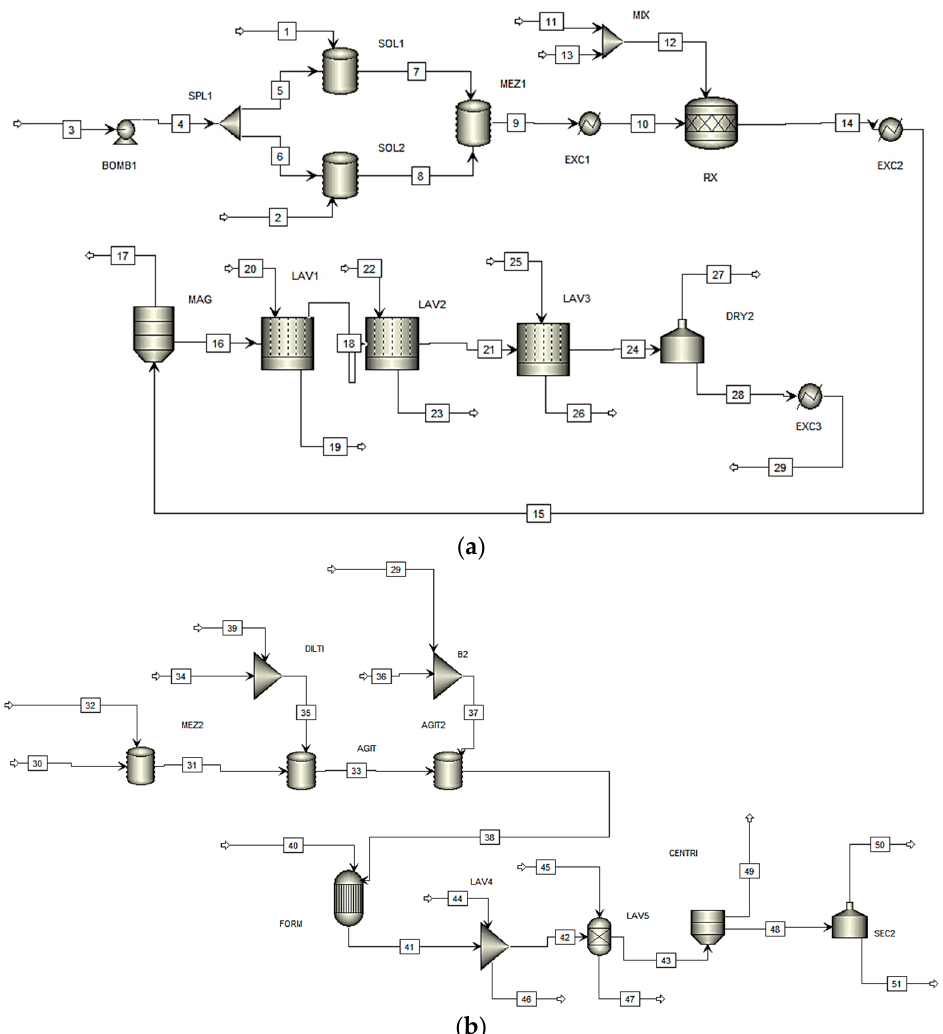
Figure 5. Process flowsheet of Large-scale production of chitosan microbeads modified with TiO 2 and magnetite nanoparticles: ( a ) Magnetite nanoparticles synthesis; ( b ) chitosan microbeads with modifications subprocess Table 3. Main process streams for chitosan microbeads modified with TiO 2 and magnetite nanoparticles.